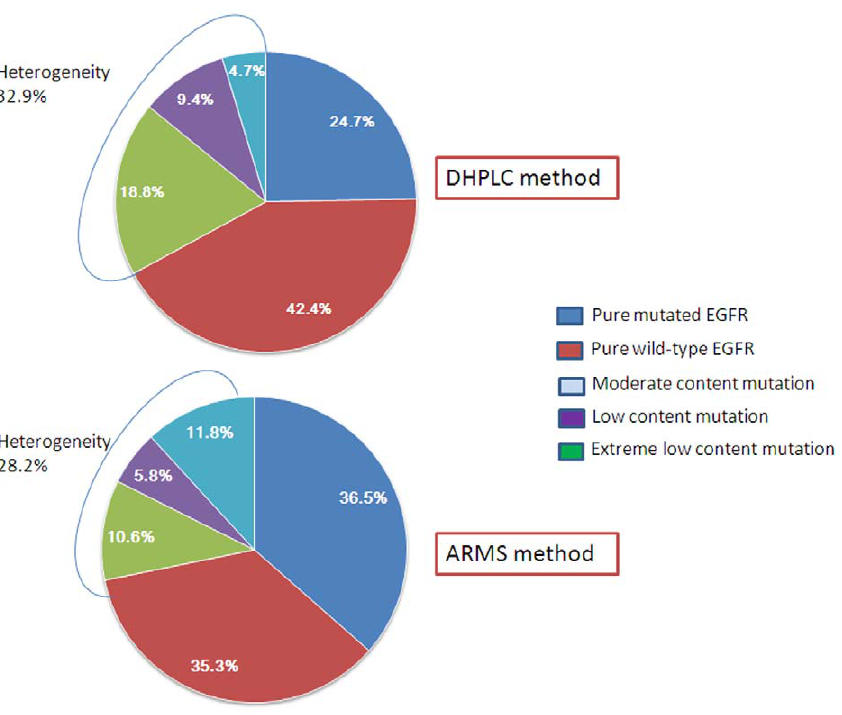
Figure 1. Heterogeneity of EGFR mutation by DHPLC and ARMS. The different color of pie represent different EGFR mutation heterogeneity. The left three parts (lightblue, purple and green) of each pie chart represent percentage of cases with EGFR heterogeneity.